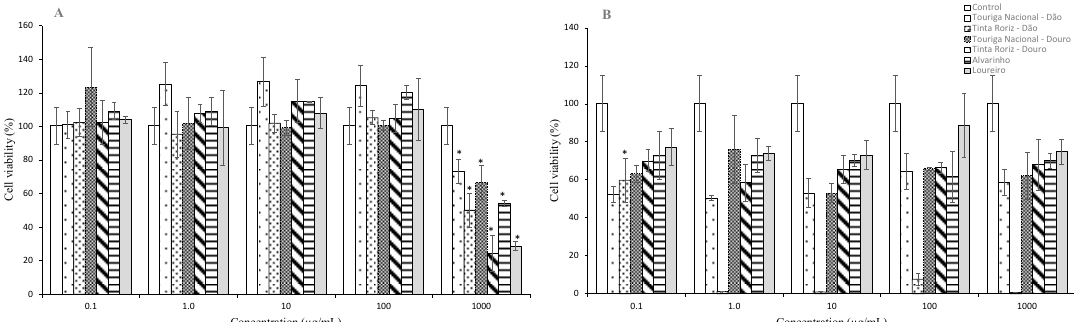
Figure 1. E ff ect of six vine-canes subcritical water extracts exposure on the viability of HaCaT cells ( A ) and HFF-1 cells ( B ) at di ff erent concentrations, as measured by the MTT assay ( n = 3; * p < 0.05 vs. control).